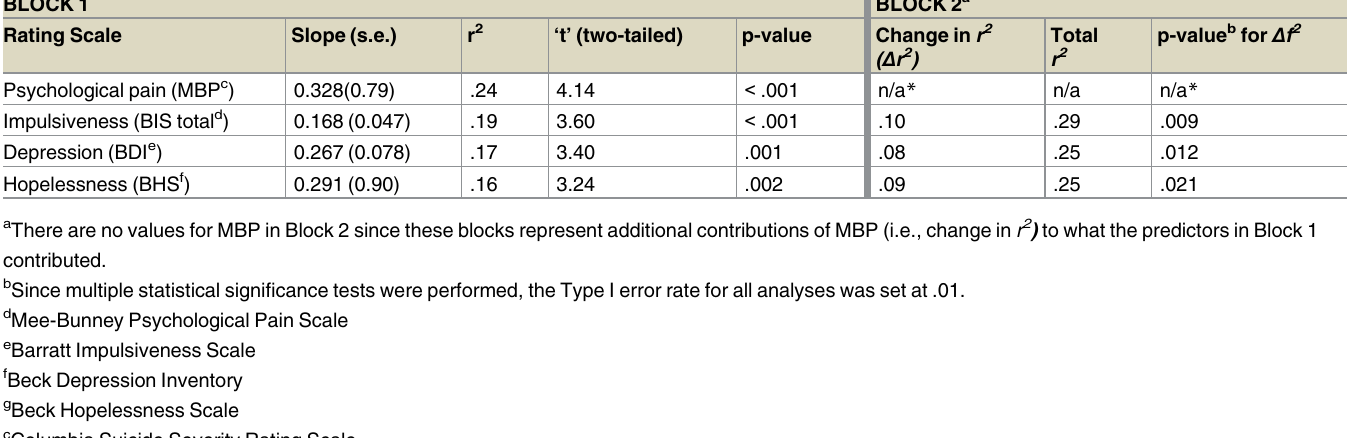
Table 3. Simple linear regression of psychological pain (MBP), impulsiveness (BIS), depression (BDI) and hopelessness (BHS) on suicidality (C-SSRS). BLOCK 1 BLOCK 2 a Rating Scale